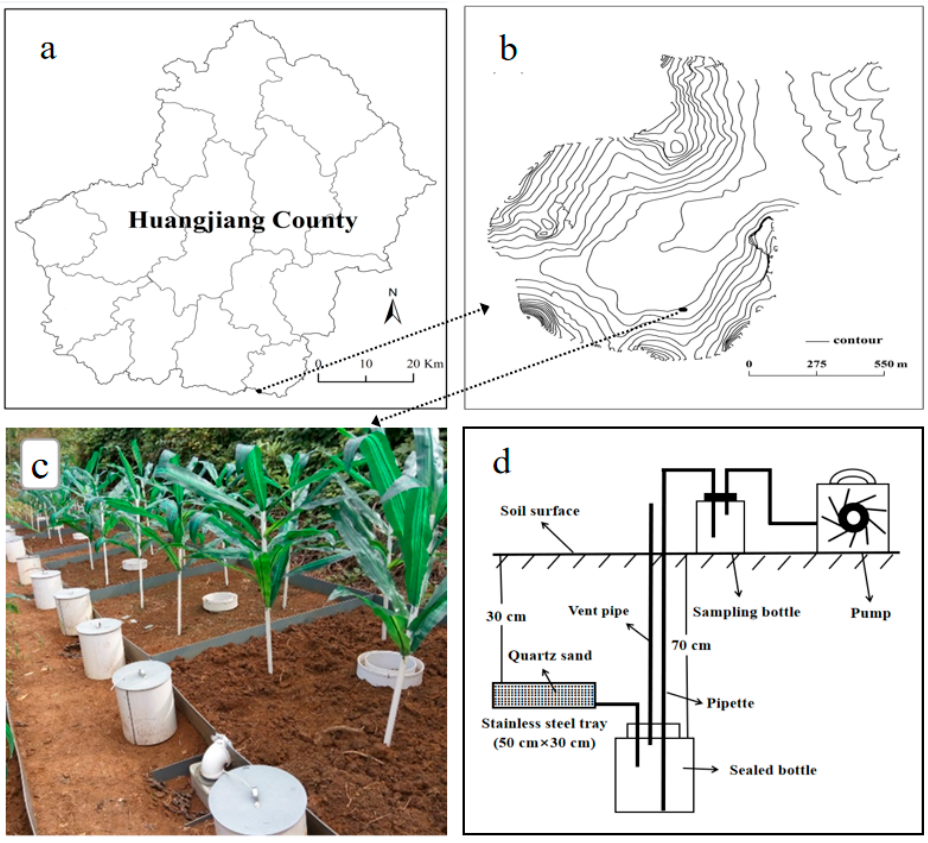
Figure 1. Map of region and field area. ( a ) Location map of the studied catchment within Huanjiang County. ( b ) Location of designed field. ( c ) Plot construction completed. ( d ) The soil-leachate-collecting device.